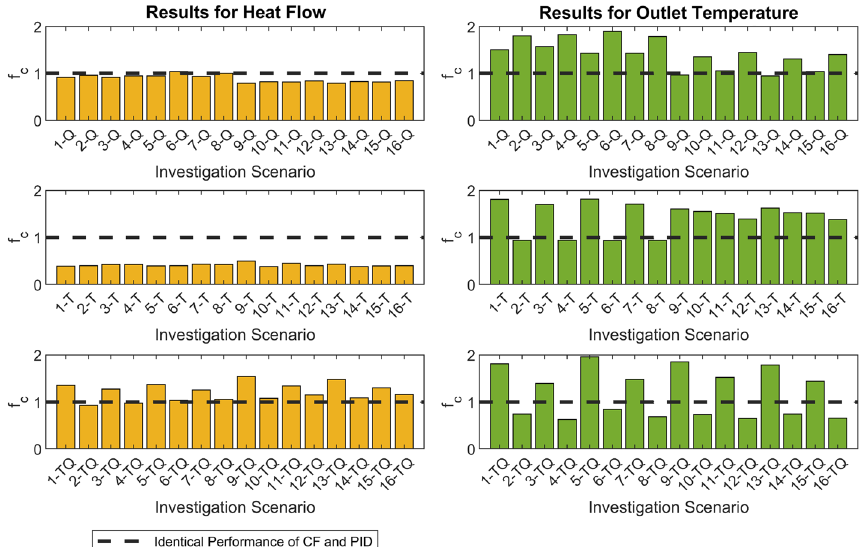
Fig. 8 Results of the comparison factors for heat flow (left side) and outlet temperature (right side) sorted by step types. Top: Q-steps; Middle: T-steps; Bottom: TQ-steps [own